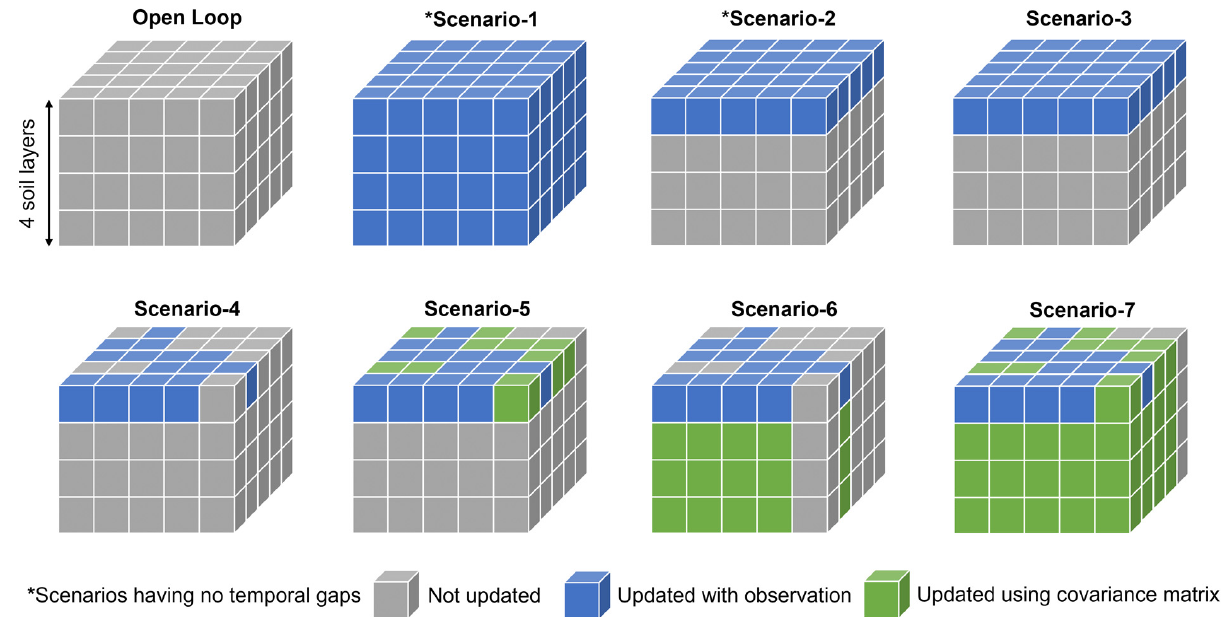
Figure 4. Different spatial configurations of soil moisture assimilation tested in this study.